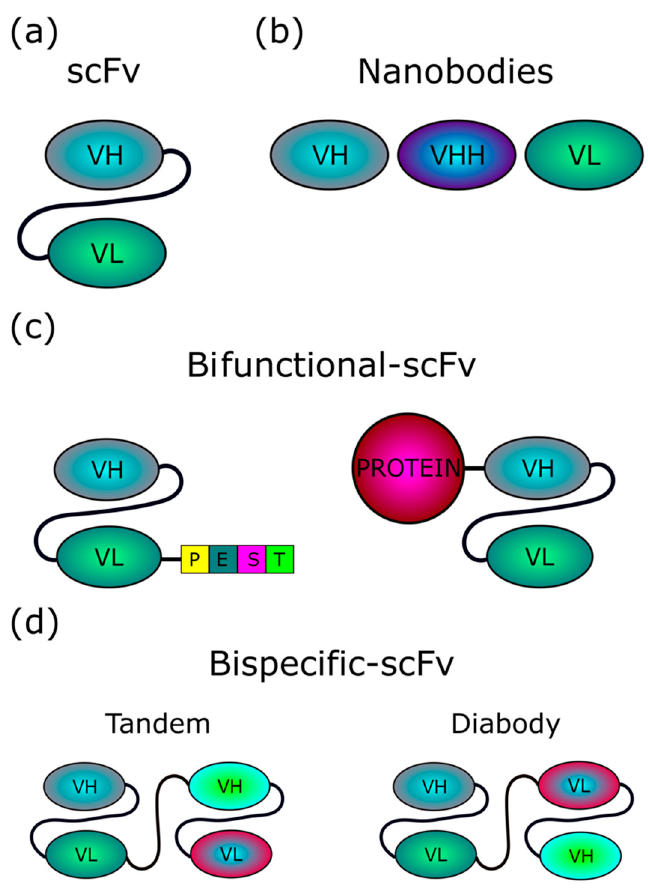
Figure 1. Structure of intrabodies. ( a ) scFvs (~30 kDa) consist of variable regions of heavy (VH) and light (VL) chains of an antibody, joined by a flexible linker, which is usually a 15-aa (Gly 4 Ser) 3 sequence. Both orientations, VH-linker-VL or VL-linker-VH, are possible. ( b ) Single domain intrabodies (~15 kDa), also termed nanobodies, consist of one single variable domain, and are referred to as VH (or VHH, for nanobodies based on naturally occurring camelid heavy-chain only antibodies), or VL, depending on the variable region included. ( c ) Bifunctional scFvs can be designed by coupling, at either the N- or C-terminus, an scFv with either a protein domain (for instance, PEST degron) able to redirect the scFv-bound target to cellular clearance machinery, or a whole protein, such as the Nef variant (~27 kDa) we propose to exploit in our exosome-based intrabody delivery strategy. ( d ) Bispecific scFvs include two scFvs with different specificity, fused either in tandem or head-to-tail (diabody).